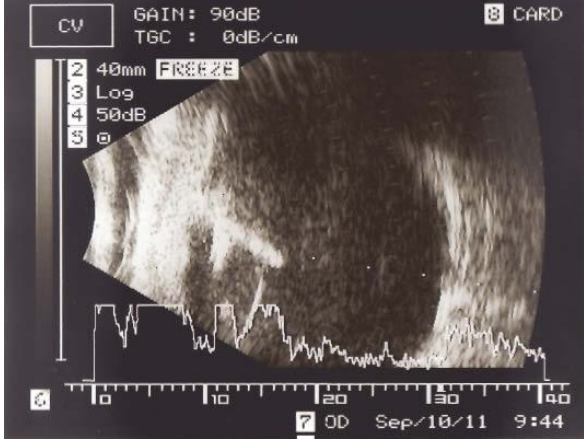
Figure 2: Ultrasonography showed an IOFB in the right eye The surgery was performed 6 hours after administered.